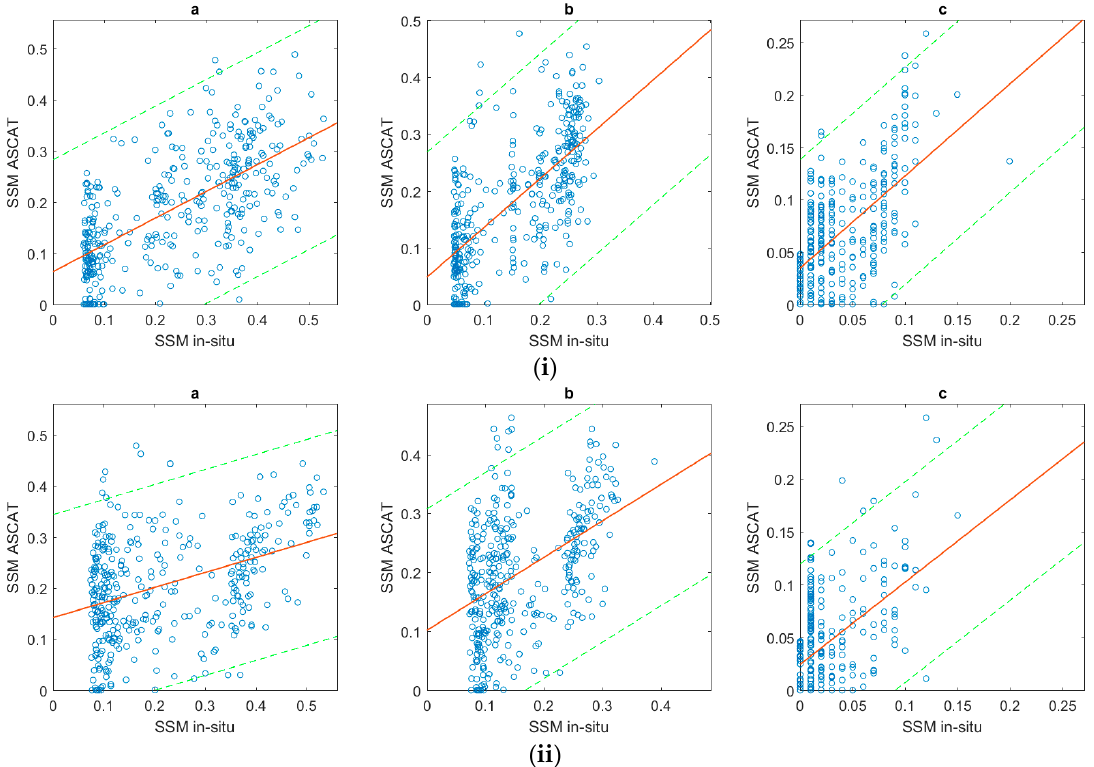
Figure 6. Scatter diagram of in situ and predicted SSM from ASCAT 25Km for the different land cover types in ( i ) 2010 and ( ii ) 2011. The USA sites include ( a ) US_TON, ( b ) US_VAR, and ( c ) US_WHS. The green dashed lines represent the 95% confidence level.